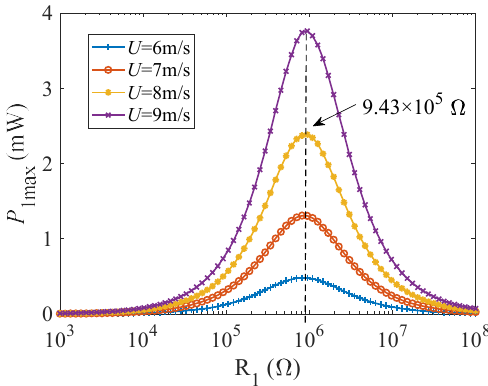
Figure 6. The curve diagram of the maximum output power P 1max of GPEH with its load resistance R 1 ( U = 6, 7, 8, 9 m/s).